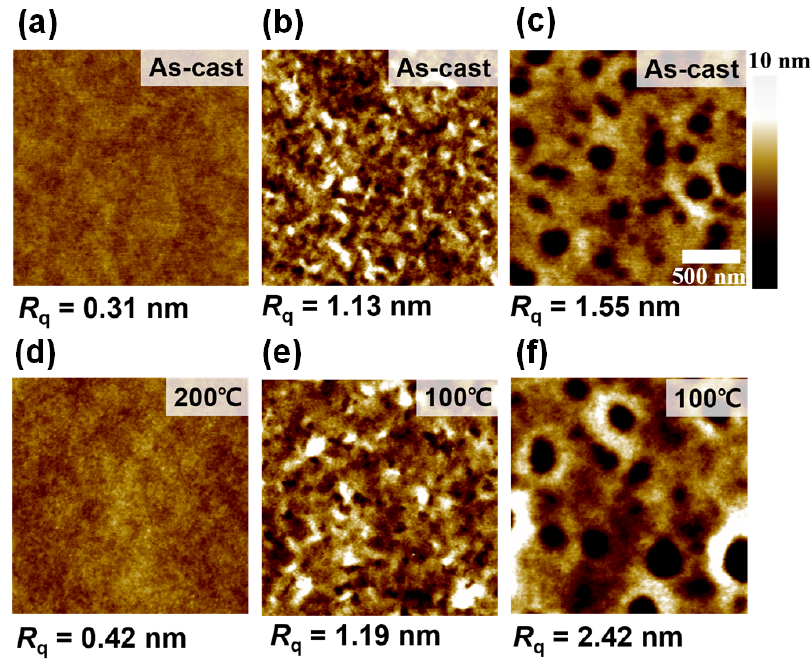
Figure 5. AFM images of ( a , d ) PBC1, ( b , e ) PBC2, and ( c , f ) PBC3 in as-casted films ( a – c ) and after thermal annealing ( d – f ).